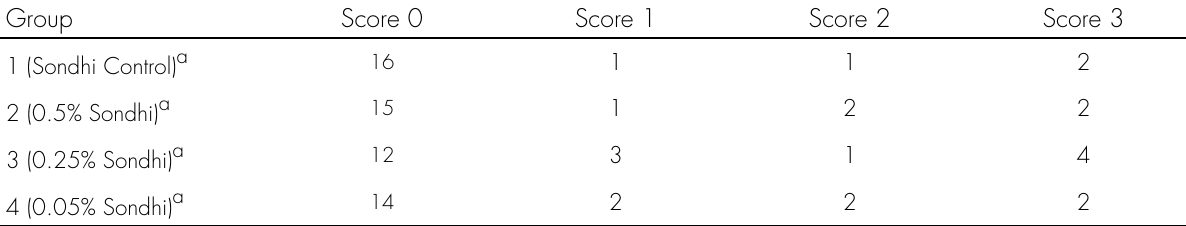
Table III. ARI scores for groups 1, 2, 3 and 4 (Sondhi).